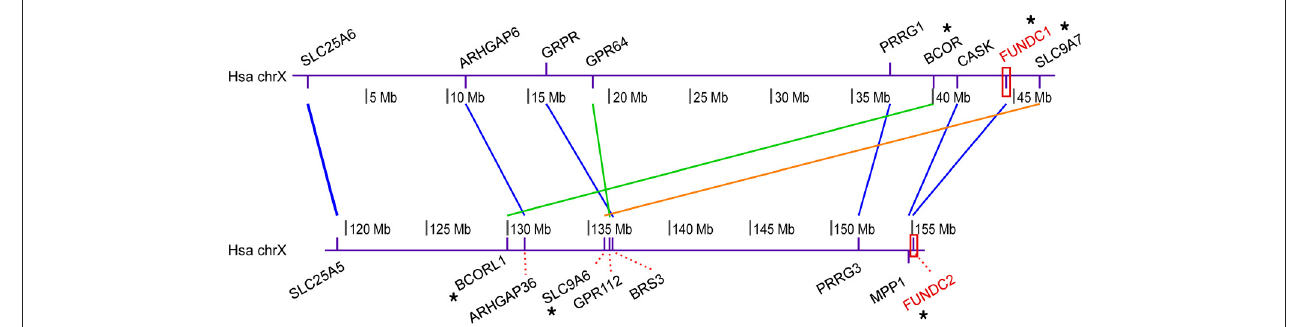
FIGURE 4 | Syntenic cluster analysis among human FUNDC1 and FUNDC2. This analysis was carried out to evaluate the hypothesis that two FUN14 domain-containing proteins in vertebrates result from WGDs in the vertebrate ancestor, as opposed to simple tandem duplications. Human FUNDC1 and FUNDC2 (labeled in red) localize in two regions with a 100-Mb distance on the same chromosome (X) (Supplementary Table 2). The online pipeline of the Synteny Database (Catchen et al., 2009) was modified in this analysis. Paralogous proteins in the human genome were retrieved through BioMart and the paralogous groups were then filtered through outgroup anchoring. Lancelet Branchiostoma floridae was used as an unduplicated outgroup (see Materials and Methods). Finally, through a manually sliding window analysis, conserved syntenic clusters (the neighboring genes of FUNDC1 and FUNDC2 keep their relative positions and orders) were detected between the two human genomic regions, which individually contain FUNDC1 and FUNDC2. Colored lines between two paralogs denote different syntenic blocks. Nine gene pairs are shared in the paralogous syntenic clusters, in which three gene pairs are recorded in the Ohnologs database ( Singh et al., 2015), which houses ohnologs—paralogous genes retained from WGD—in six vertebrate genomes.